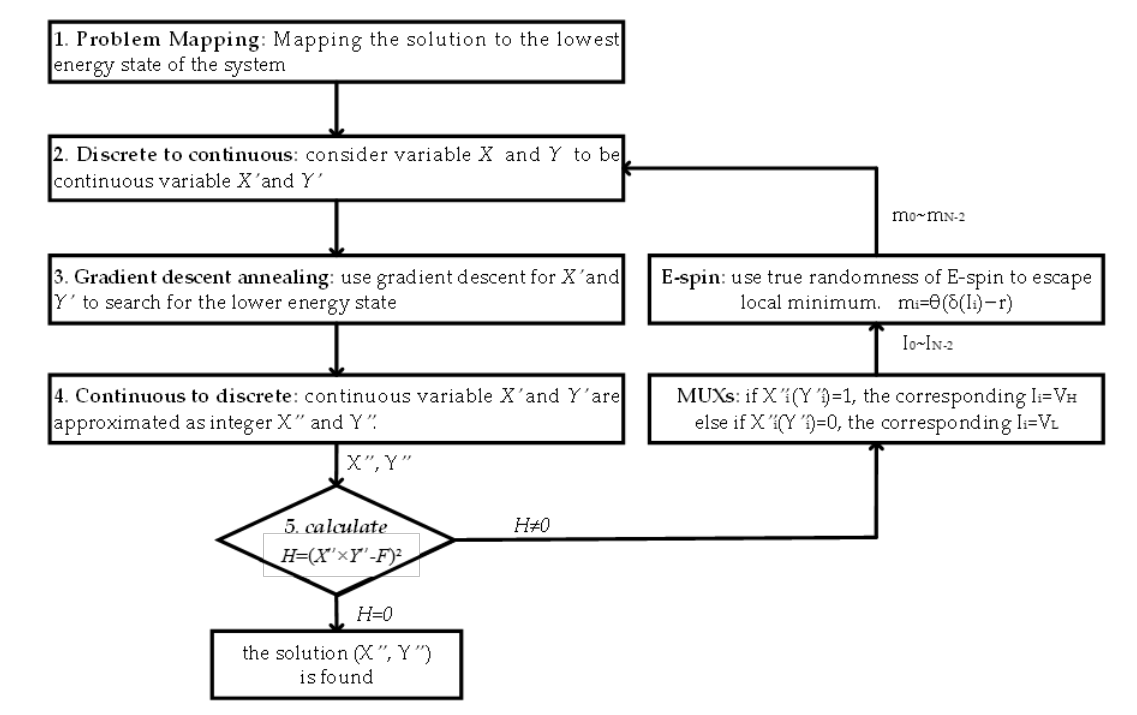
Figure 5. The framework of the proposed Ising annealing algorithm QFactor. H=(X ″ × Y ″ -F)